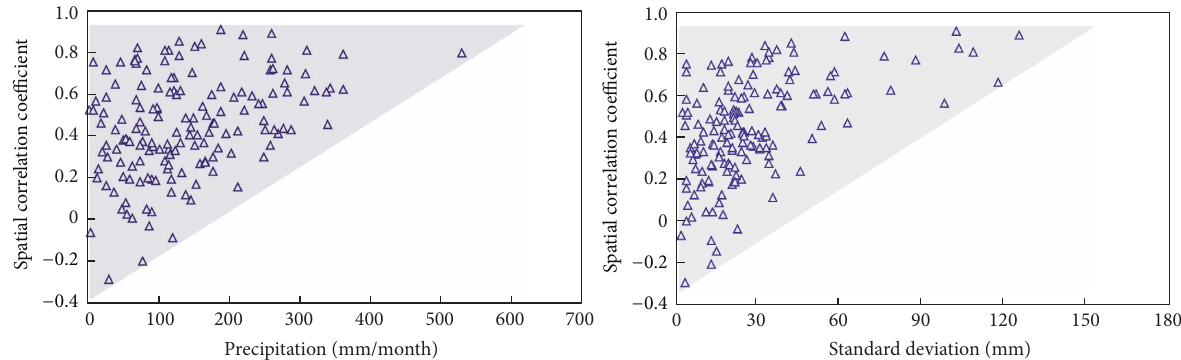
Figure 8: Scatter plots of spatial agreement versus average monthly rainfall and standard